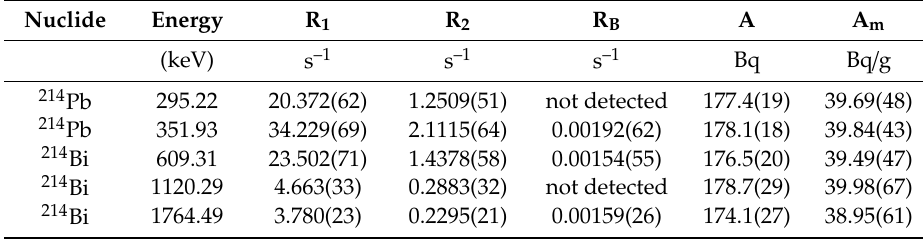
Table 3. Detected gamma rates R 1 , R 2 , and R B (first and second sample and background, respectively) for the five most intensive gamma lines and the calculated 226 Ra activities A and specific activities A m . Combined standard uncertainties are shown in parentheses.